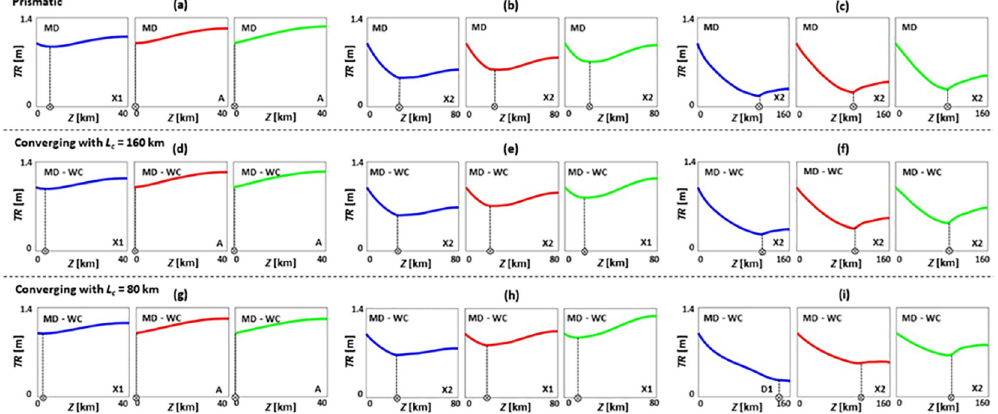
( Z = 160 km). Blue, red, and green colours show base case (no SLR), 1 m of SLR, and 2 m of SLR scenarios, respectively. Patterns A, X1, X2, and D1 are the general TR patterns introduced in Fig 2. MD and WC refer to moderately dissipative and weakly converging estuaries,